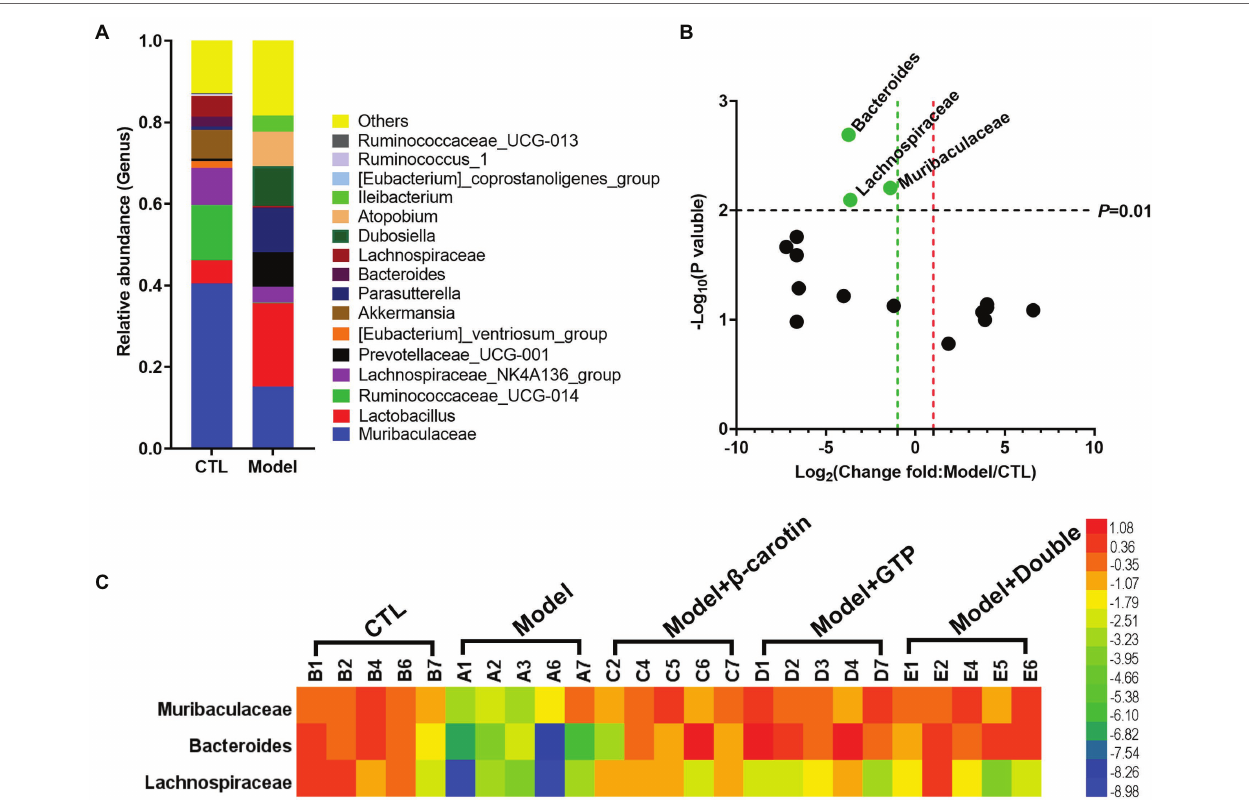
FIGURE 5 | Comparative analysis of key bacteria at the genus level in five groups of mice. (A) Comparison of microbial differences between the mice in Model and control group (CTL) groups showing the microbial taxa with the average relative abundance >1%. (B) Volcano graph analysis of changes in the gut microbiota of mice in Model and CTL groups. The p value is based on the t -test. Bacteria with a relative abundance >1% in (A) are selected as key bacteria. (C) The heat map showing the relative abundance of key bacteria in each sample of the five groups of